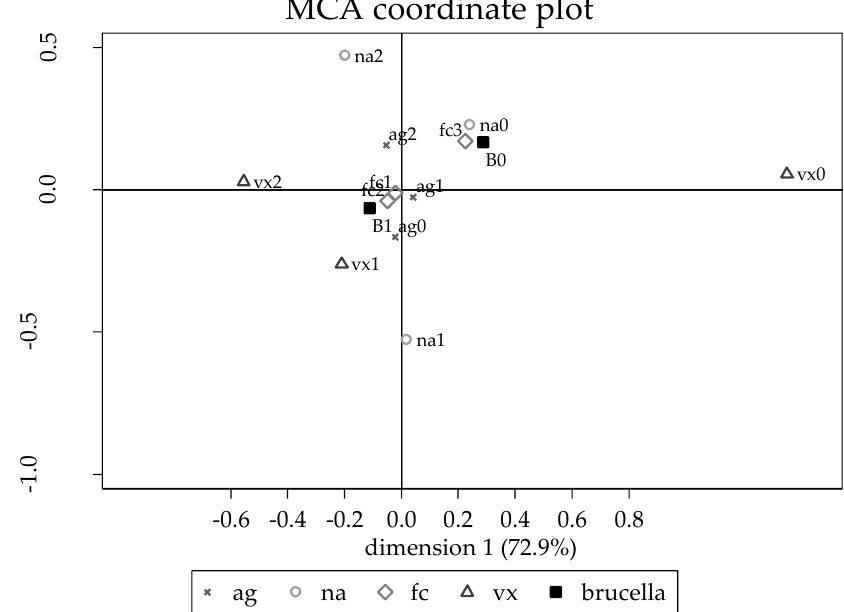
Figure 3. MCA plot of risk factors for Brucella seropositivity in Guwahati, India. Ai = Artificial insemination, where ai0 is no artificial insemination and ai1 is use of artificial insemination. Na = number of animals, where na0 is less than 7 animals and na1 is 7–10 animals. Fc = floor cleanliness, where fc0 is clean or moderately clean floor and fc1 is dirty floor. Vx = vaccination, where vx0 means no vaccination done, vx1 means vaccination when there is an outbreak or when given free vaccines, and vx2 means vaccinating animals as young. B = Brucella , where B0 = seronegative farm and B1 = seropositive farm. Table 3. Risk factors for Brucella seropositivity within Guwahati, India, using a mixed logistic regression model.